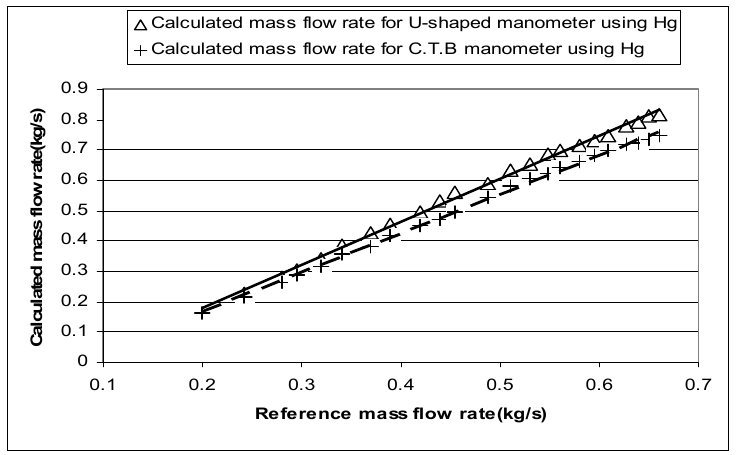
as sensing fluid. 4